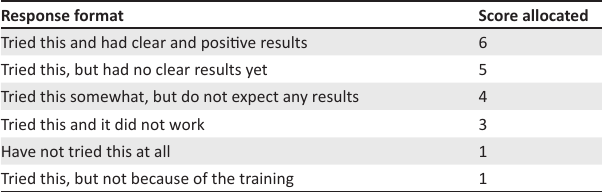
TABLE 2: Response format and scoring in the survey.